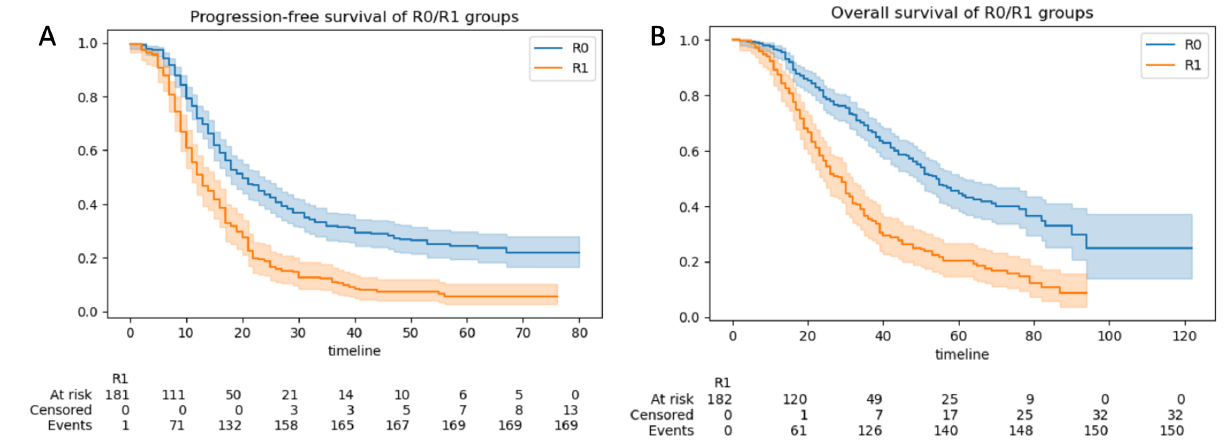
Figure 6. Cohort survival outcomes according to the residual disease (R0 vs. non-R0 (R1)). Kaplan– Meier curves demonstrating ( A ) progression-free survival (PFS) and ( B ) overall survival (OS) ana- lyzed by R0 and non-R0 (R1) groups. The blue line represents the patients with R0 resection, and the orange line those with the non-R0 resections. Confidence intervals (CIs) are illustrated.